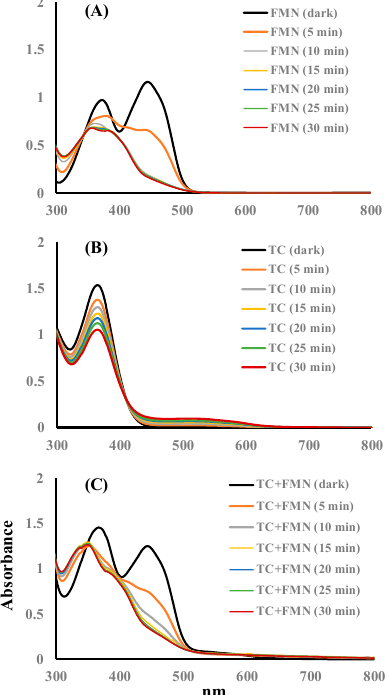
Figure 3. Absorption spectra after 0–30 min of blue light irradiation at 20 W / m 2 of ( A ) 50 µ g / mL of FMN, ( B ) 50 µ g / mL of TC, and ( C ) 50 µ g / mL of FMN in the presence of 50 µ g / mL of TC. The absorbances of the reaction solutions were collected in the wavelength from 300 to 800